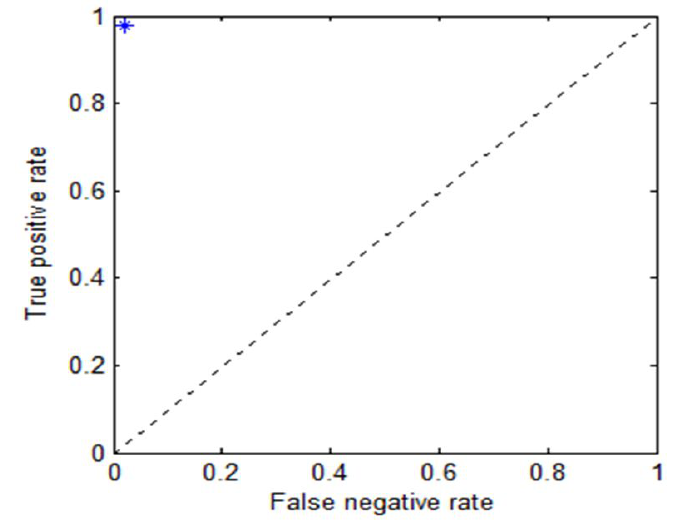
Figure 10. ROC graph showing the SVM